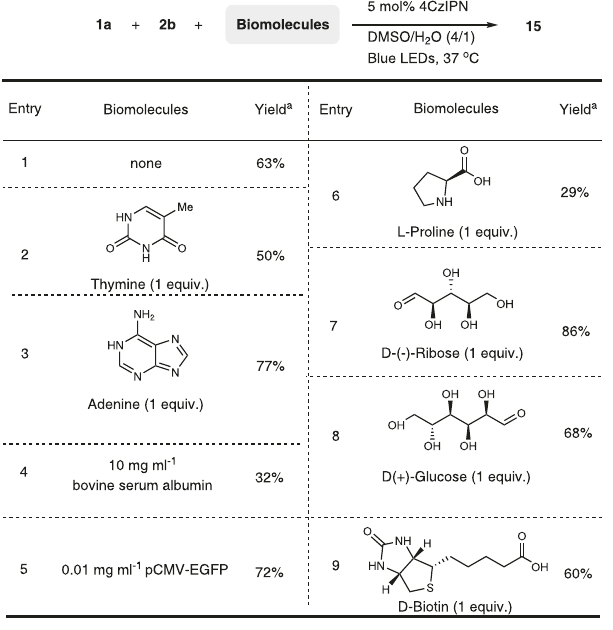
Fig.6|Examiningfunctionalgroupcompatibility. Conditions:Allreactionswere carried out with 4CzIPN (5mol%), 1a (0.2mmol), 2b (0.1mmol), biomolecule, and DMSO (0.03M)irradiated under 15W Blue LEDsat60°C. a Yieldswere determined by HPLC analysis.